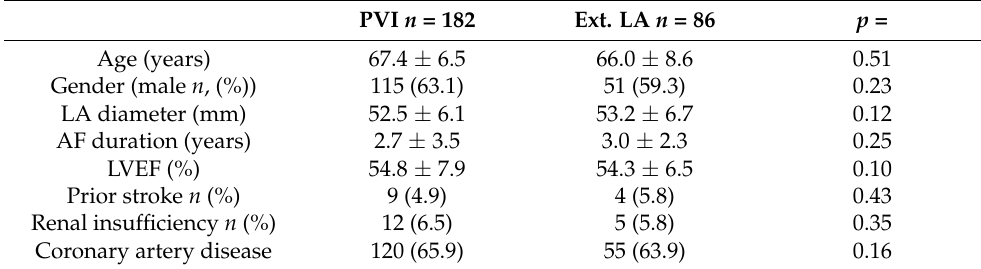
Table 1. Patient baseline